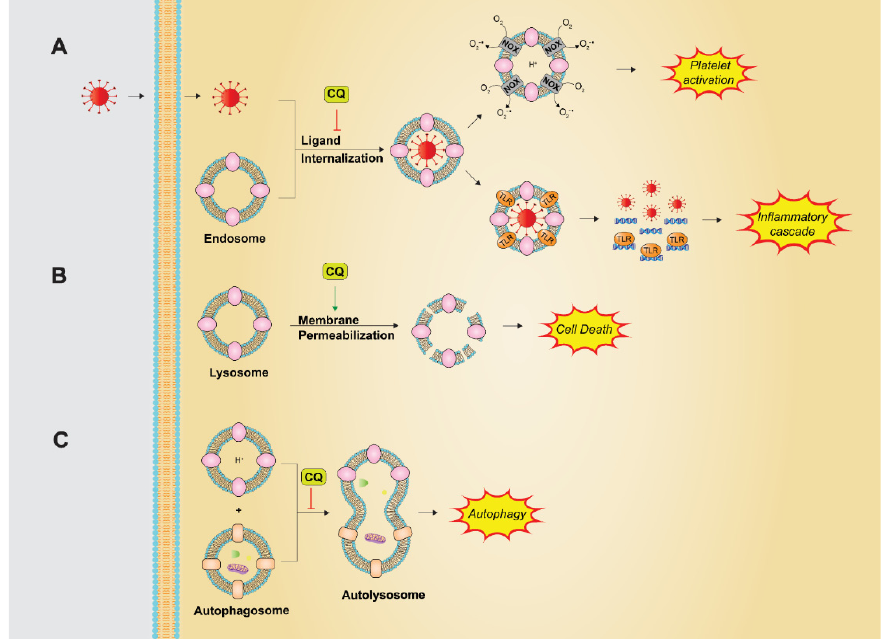
Figure 2. Summary of proposed mechanisms of actions of CQ.